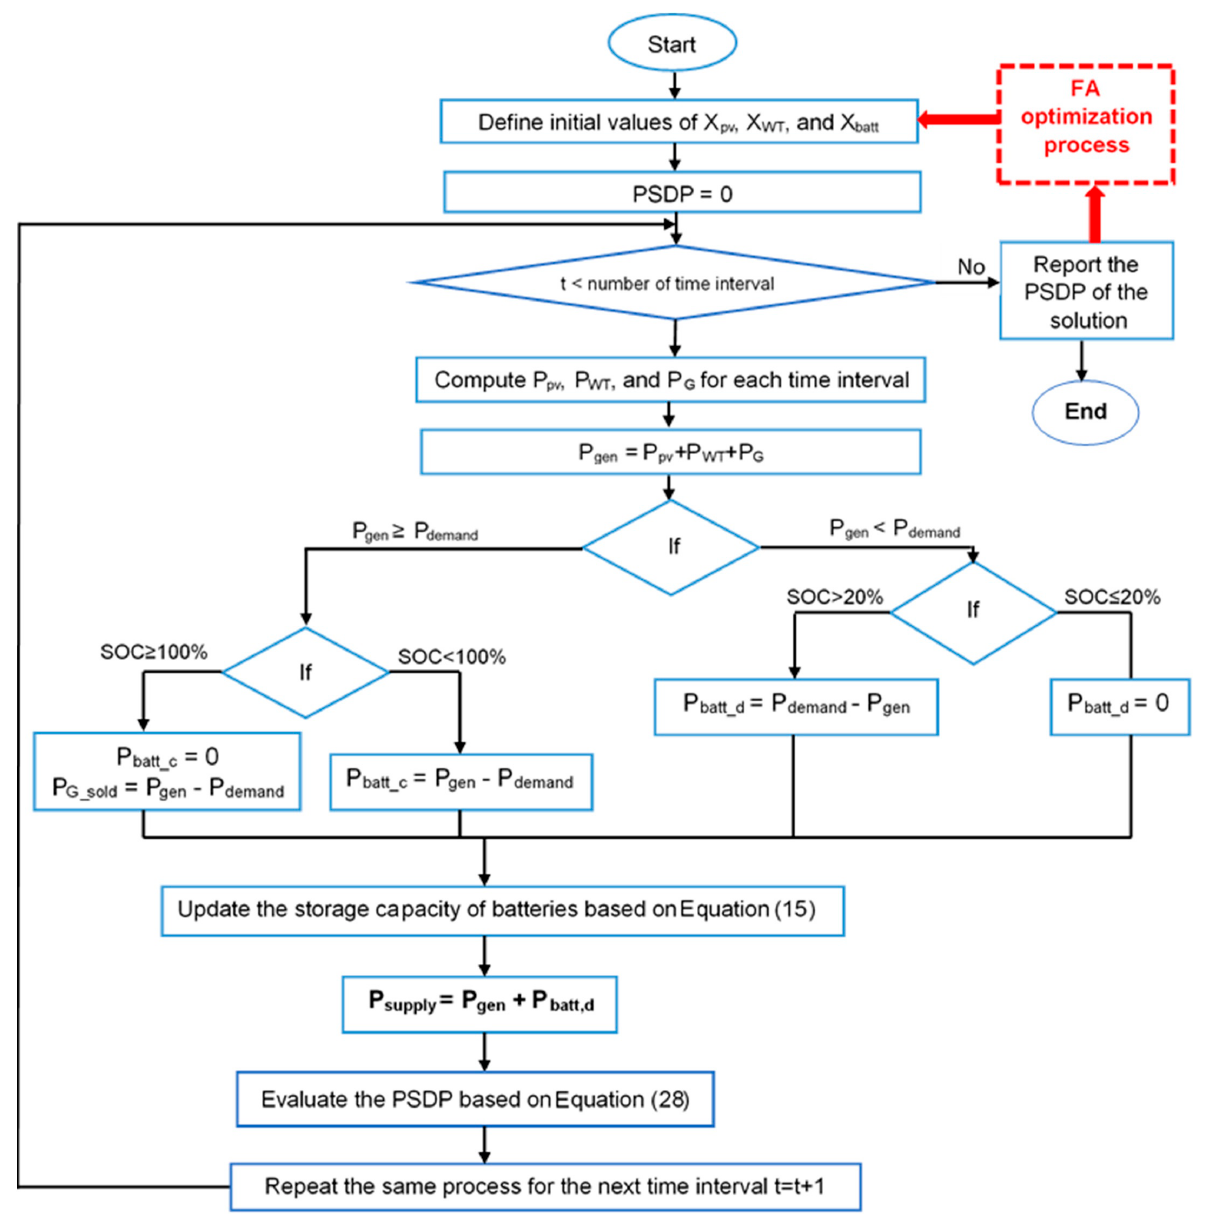
Figure 6. Operational